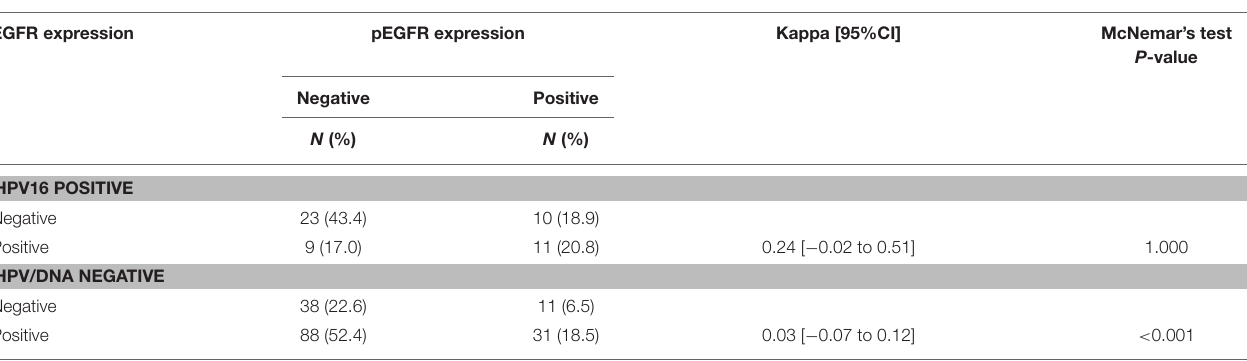
TABLE 2a | Concordance between EGFR and pEGFR expression by HPV status. EGFR